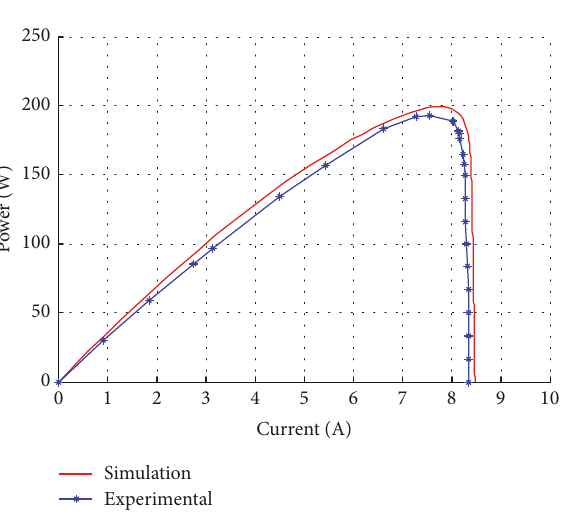
Figure 21: The 𝑃 - 𝐼 characteristics of PFV ALTIUS 235W.